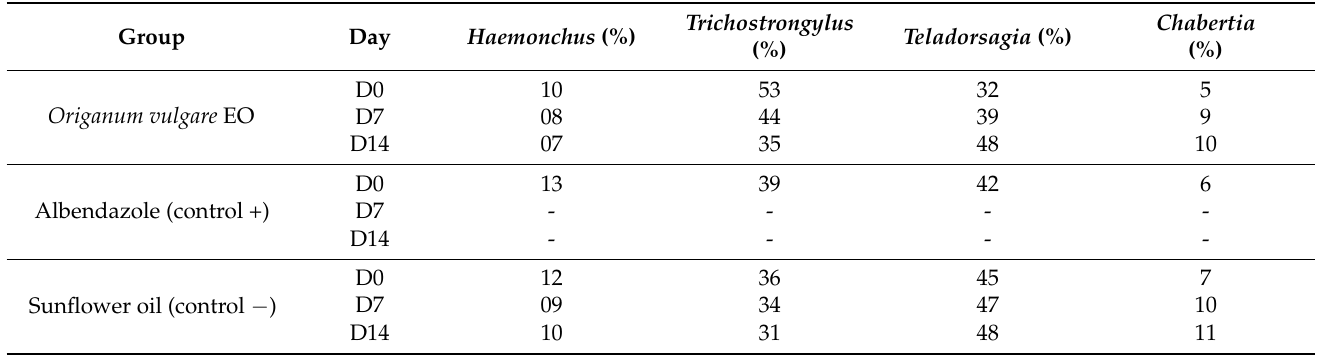
Table 5. Percentage of sheep nematode third-stage larvae (L3) for each group at D0, D7 and D14 in sheep farm 1.